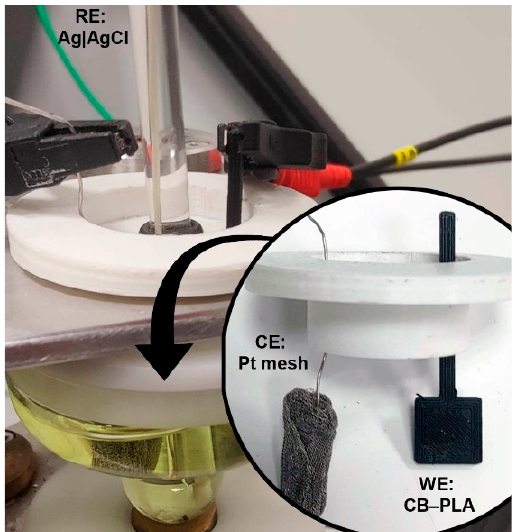
Figure 7. The electrochemical setup containing the CB–PLA working electrode, printed after three reprocessing cycles of the filament.